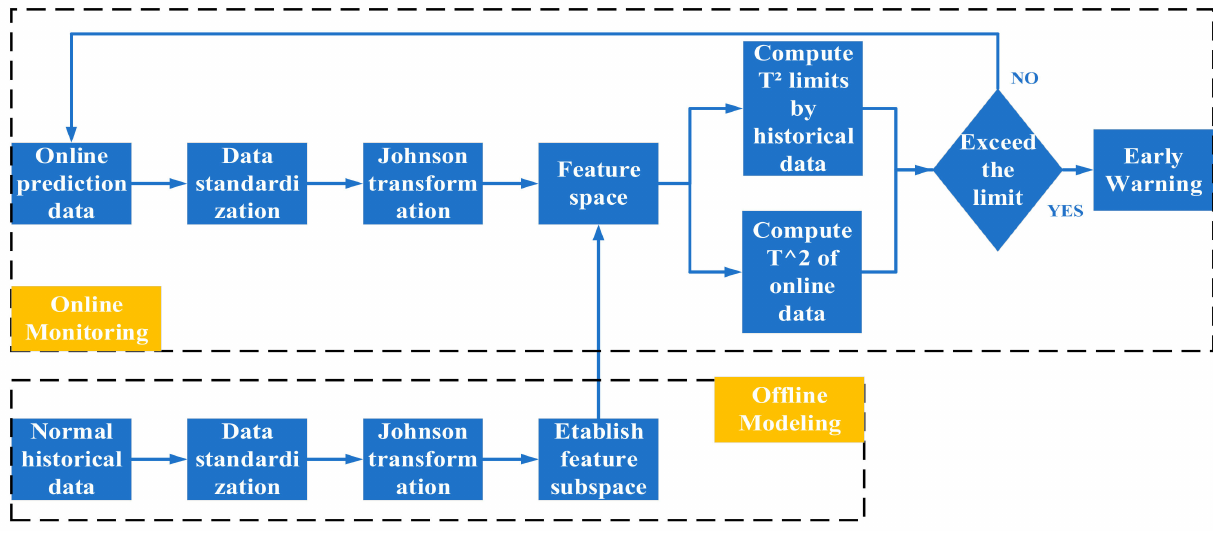
Figure 10. Online and offline modeling